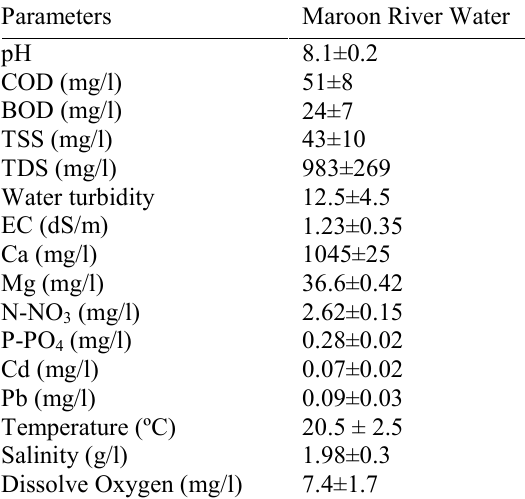
Table 1. Physicochemical properties of maroon river water